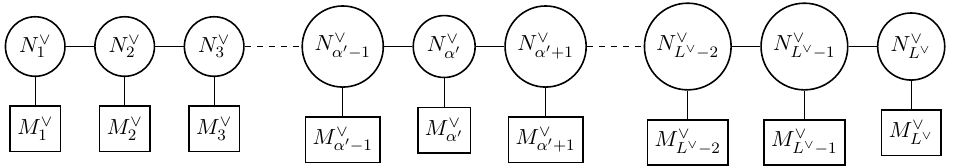
Figure 7 . The linear quiver which is mirror dual to the generic linear quiver in figure 3. The total number of gauge nodes is L ∨